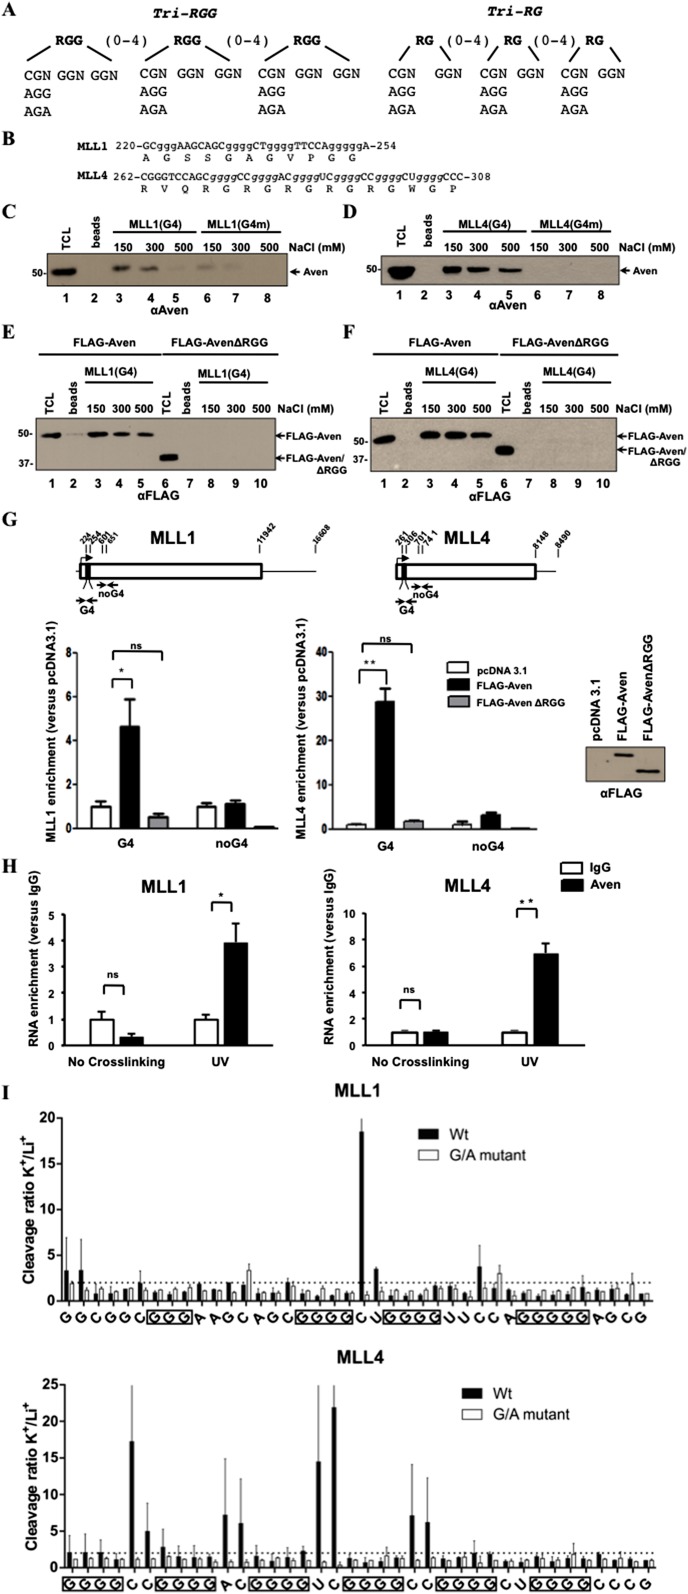
Aven RGG/RG motif binds G4 RNA structures of MLL1 and MLL4.(A, B) RNA sequences of the RGG/RG motifs and the PG4 motifs of MLL1 and MLL4. (C, D) Biotinylated MLL1 G4 or a mutant sequence (G4m), biotinylated MLL4 G4 or a mutant sequence (G4m) bound to Streptavidin beads were incubated with HEK293T cell lysates. The bound proteins were washed with increasing concentrations of NaCl and visualized by SDS-PAGE followed by immunoblotting with anti-Aven antibodies. (E, F) HEK293T cells expressing FLAG-Aven and FLAG-AvenΔRGG were processed as in panel C, D except the bound proteins were visualized by immunoblotting with anti-FLAG antibodies. (G) Photocrosslinking IP experiments were performed using anti-FLAG antibodies. The bound RNA was analyzed in triplicate from two biological replicates by RT-qPCR with the primers spanning the PG4 sequence or a sequence ∼300 nucleotides downstream. The levels of bound RNA in immunoprecipitates were normalized to the levels of the total RNA in the input. Mean values are expressed as fold enrichment over pcDNA3.1. Error bars represent ±SEM. *p < 0.05, **p < 0.001, n.s. non-significant. The experiment was performed twice. (H) Photocrosslinking IP experiments were performed on HEK293T cells using anti-Aven antibodies. The bound RNA was analyzed in triplicates by real-time RT-PCR with the primers spanning the PG4 sequence, as indicated in panel G. The level of bound RNA in immunoprecipitates was normalized to the levels of the total RNA in the input. Mean values are expressed as fold enrichment over IgG. Error bars represent ±SEM. *p < 0.05, **p < 0.001, n.s. non-significant. The experiment was performed twice. (I) In-line probing of MLL1 and MLL4 PG4. The nucleotide sequence of the mixed lineage leukemias (MLLs) PG4 is shown below, the boxed guanines represent the predicted G-tracks. K+/Li+ ratios of the band intensities of the MLLs G4 (black) and G/A-mutant (white) for each nucleotide are shown. Error bars represent ± standard deviation. The experiment was performed twice. The dashed line represents a twofold change, an arbitrary set threshold that indicates G4 formation when exceeded.DOI:
http://dx.doi.org/10.7554/eLife.06234.01110.7554/eLife.06234.012Figure 5—source data 1.G4 sequences in coding regions of mRNAs.